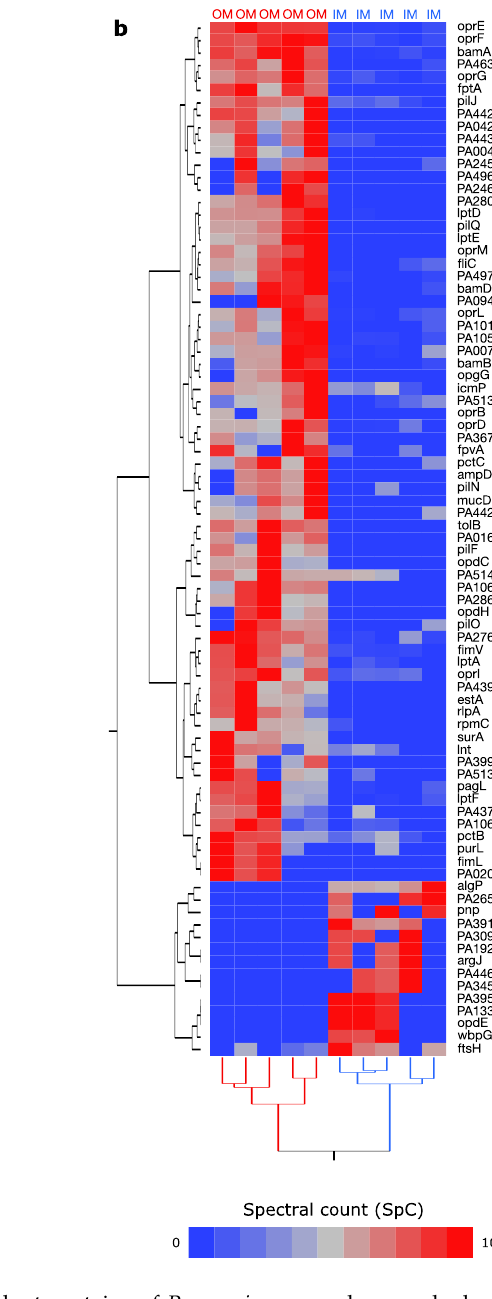
Figure 3. ( a ) Histogram showing the 20 most abundant proteins of P. aeruginosa envelope ranked based on total average spectral count normalized on protein length (ntaSpC). Blue border indicates proteins located in membrane. ( b ) Proteins differentially enriched between inner (IM) and outer membrane (OM). Proteins were extracted by Linear Discriminant Analysis (LDA), p < 0.05); hierarchical clustering performed by Ward’s methods and Euclidean distance (JMP15.1 software) by processing Spectral Count (SpC) of identified proteins. ( c ) Cellular components enriched from the characterized P. aeruginosa membrane proteome ( n = 2539). The number of proteins per sub-cellular component is shown. Blue bars indicate cellular components related to membranes. Data were retrieved from Panther (www.pantherdb.org); FDR ≤ 0.05, Fisher’s Exact test ≤